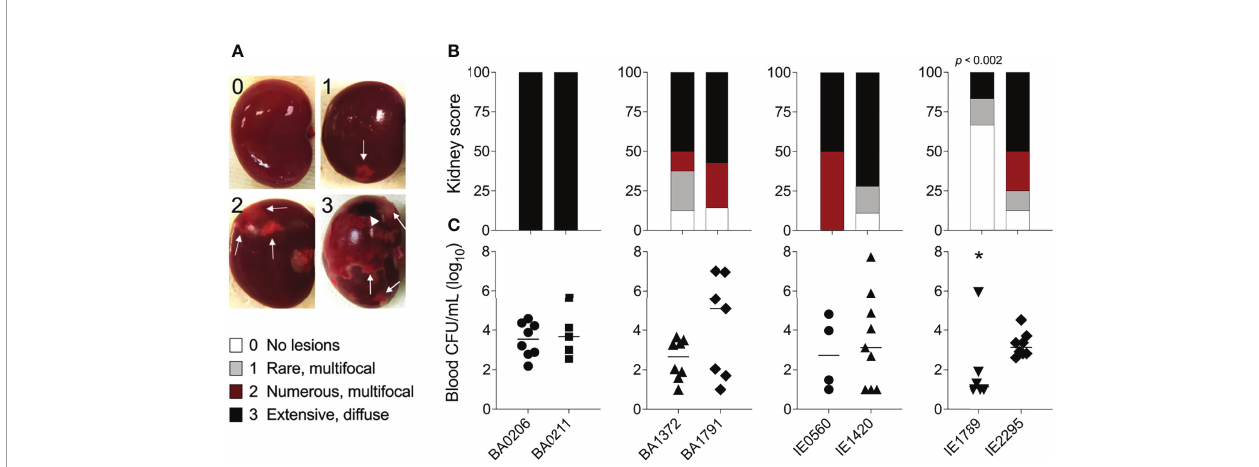
FIGURE 2 | Acute kidney injury and bacteremia resulting from S. aureus CC5 IE. Rabbit model of native valve IE and sepsis. Rabbits were injected intravenously with 1.3 – 3.6 x 10 7 cfu of S. aureus CC5 isolates after mechanical damage of aortic valve and monitored over 4 days. (A) Kidney gross pathology grading scale (grades 0-3). 0 = no lesions, 1 = rare, small (<4mm) multifocal lesions, 2 = numerous large (>5mm) multifocal lesions, 3 = extensive to coalescing to diffuse lesions. Arrows indicate ischemic and/or hemorrhagic lesions, arrowhead indicates a necrotic lesion. (B) Scoring of kidney lesions post-mortem . One-way ANOVA with Fisher ’ s LSD multiple comparisons test across strains. p < 0.002, IE1789 compared to the rest of the strains. (C) Bacterial counts per milliliter of blood recovered from rabbits post-mortem . Lines represent median value. *, p < 0.02, one-way ANOVA Kruskal-Wallis test with uncorrected Dunn ’ s multiple comparison test across